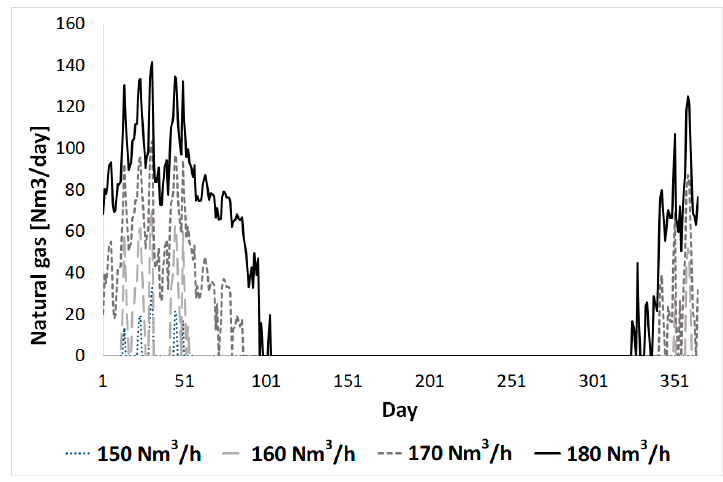
Figure 14. The natural gas consumption in the auxiliary boiler for various sizes of upgrading system.